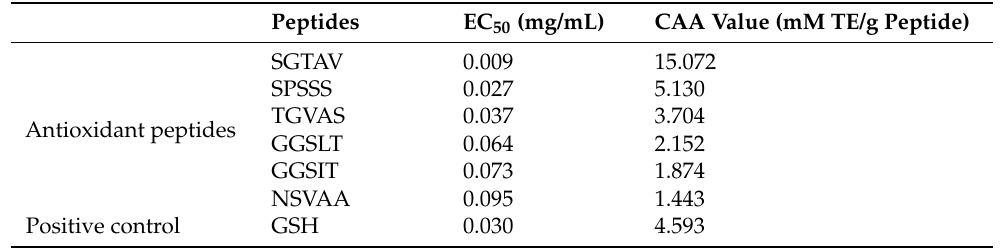
Figure 3. Evaluation of antioxidant activity of antioxidant peptides SPSSS, SGTAV, TGVAS, GGSIT, NSVAA, and GGSLT on HepG2 cells. ( A ) Effect of antioxidant peptides on HepG2 cells viability. ( B ) CAA unit of antioxidant peptides and positive control (GSH). Different letters (a–d) indicated significant differences among the various concentrations ( p < 0.05) of each sample. Table 2. The median effective concentrations (EC 50 ) and cellular antioxidant activity (CAA) values of six antioxidant